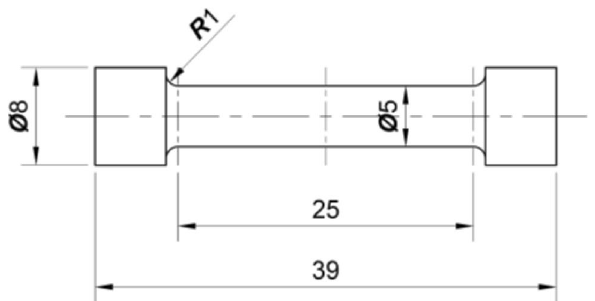
Fig. 1 Schematic diagram of tensile and impact strength specimen as per standard ASTM E8M‑89b — Unit: